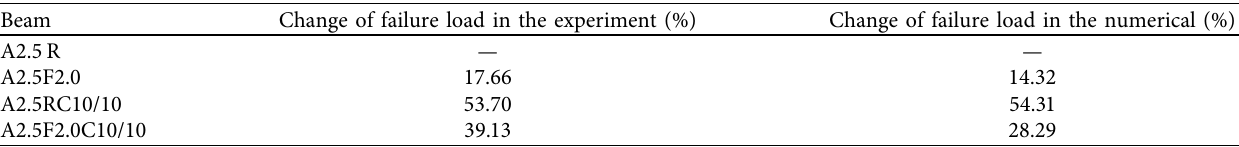
Table 8: The percentage change in deflection values obtained from the experimental approach and numerical simulation. Beam Change of deflection in the experiment (%) Change of deflection load in the numerical (%) A2.5 R — — A2.5F2.0 59.91 59.8 A2.5RC10/10 88.23 87.98 A2.5F2.0C10/10 67.77